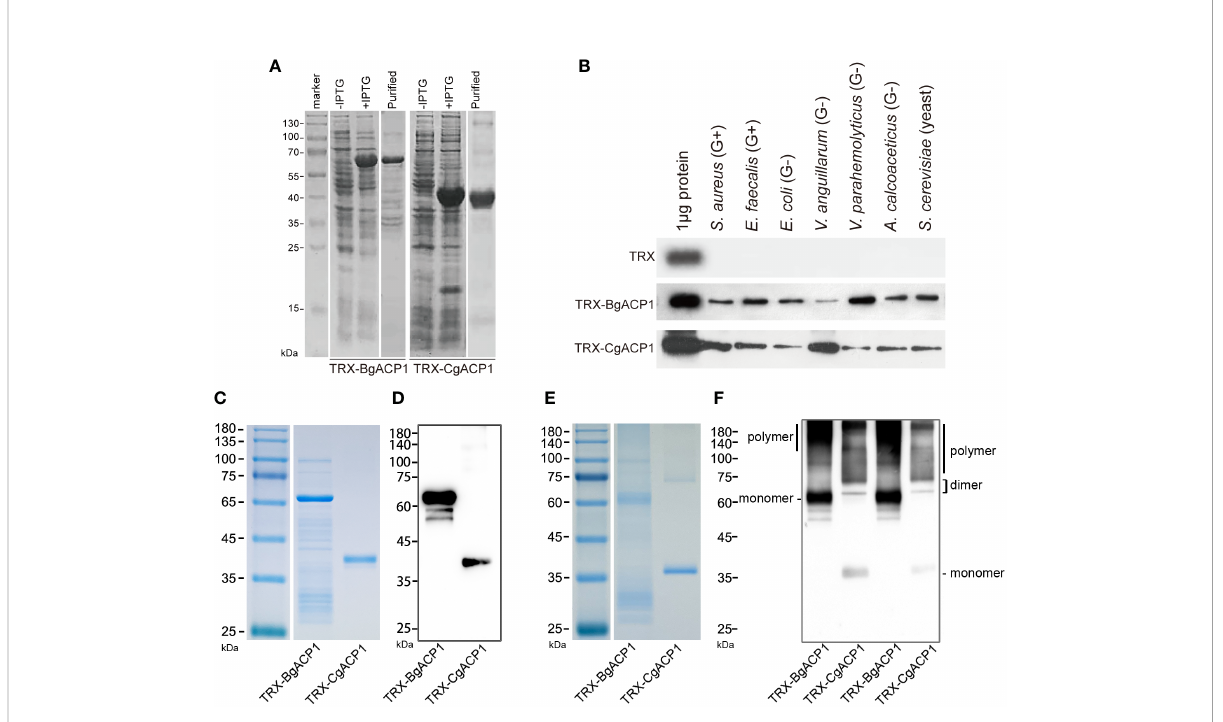
FIGURE 4 The bacterial binding capacity of recombinant CgACP1 and BgACP1. (A) SDS-PAGE analyses of samples collected during the puri fi cation of recombinant TRX-CgACP1 and TRX-BgACP1. (B) The binding of microbes by recombinant TRX-CgACP1 and TRX-BgACP1 protein. One representative experiment out of three is shown. (C) Coomassie Blue staining of the reduced SDS-PAGE of recombinant TRX-CgACP1 and TRX- BgACP1. (D) Western blotting of the reduced SDS-PAGE with anti-His Tag antibodies shows that multimerized recombinant TRX-CgACP1 and TRX-BgACP1 were broken down to a single band of monomers. (E) Coomassie Blue staining of the non-reduced SDS-PAGE of recombinant TRX-CgACP1 and TRX-BgACP1. (F) Western blotting of the non-reduced SDS-PAGE with anti-His Tag antibodies shows the bands of monomers, dimers and polymers of recombinant TRX-CgACP1 and